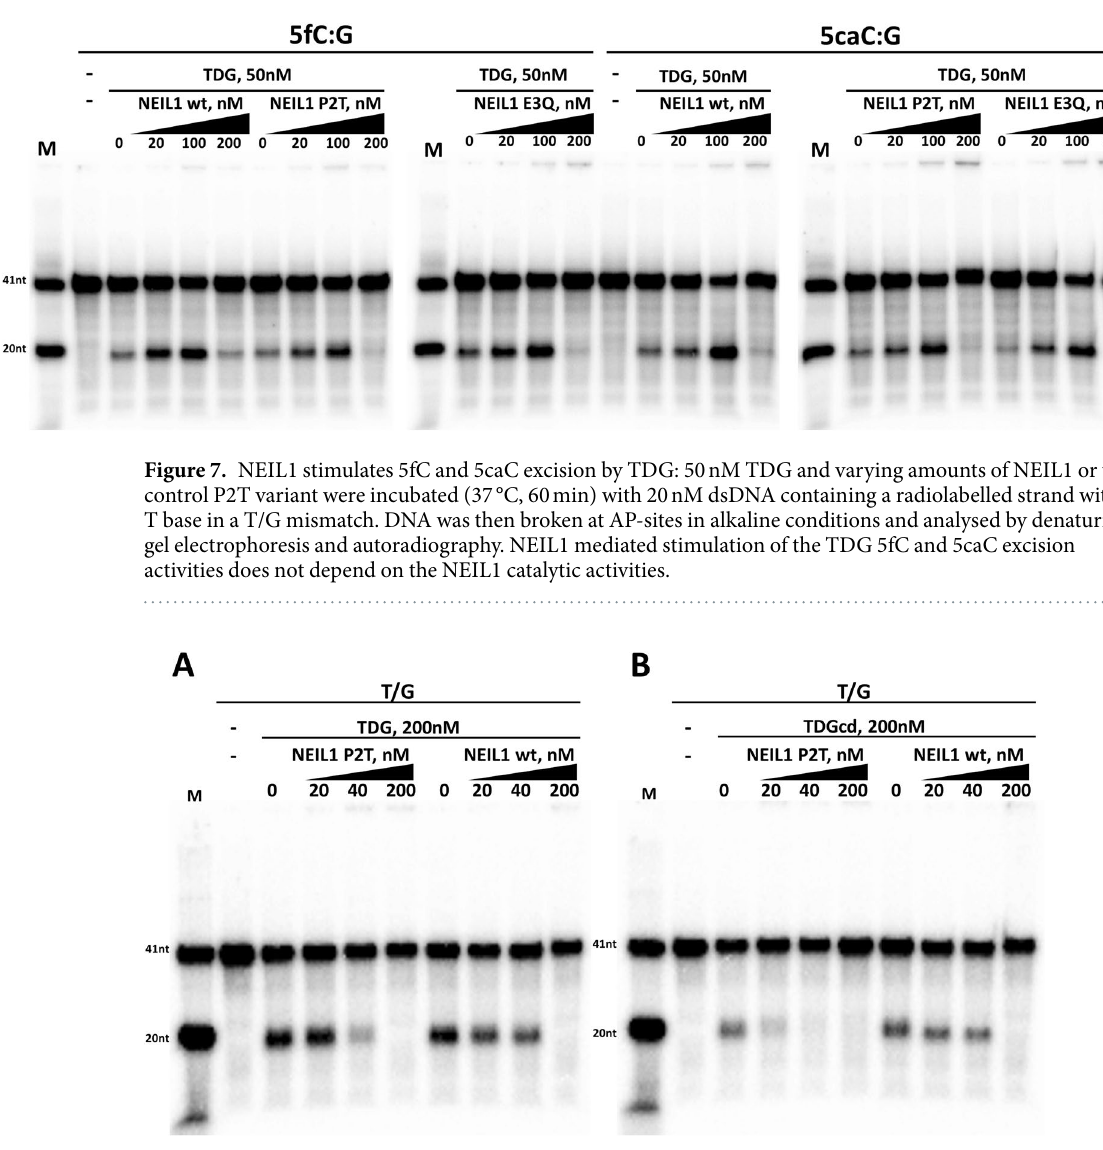
Figure 8. NEIL1 interferes with TDG activity on a T/G mismatch: 50 nM TDG and varying amounts of inactive NEIL1 P2T or NEIL1 wt were incubated (37 °C, 60 min) with 20 nM dsDNA containing a radiolabelled strand with T/G mismatch. DNA was then broken at AP-sites by in alkaline conditions and analysed by denaturing gel electrophoresis and autoradiography. Interference of NEIL1 with TDG glycosylase activity towards the T/G mismatch substrate was independent of the NEIL1 catalytic activities. The NEIL1 inhibits both full-length TDG ( A ) and TDGcd ( B